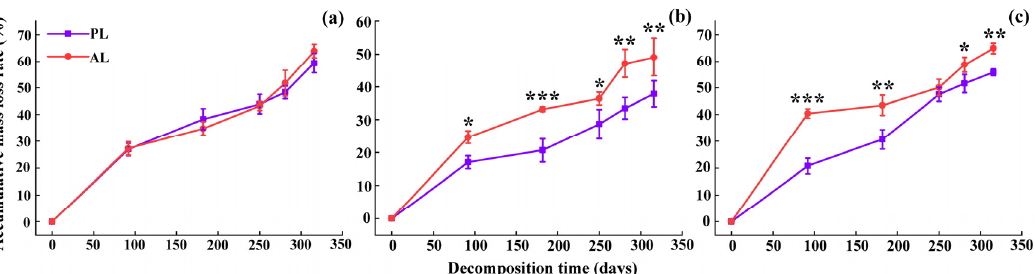
Figure 2. The accumulative mass loss rates (%) of goldenrain tree ( a ), camphor tree ( b ), and weeping willow tree ( c ) foliar litter in the urban forest. PL and AL indicate physiological and abnormal litter, respectively. * p < 0.05, ** p < 0.01, *** p < 0.001. Table 2. The decomposition constant, correlation coefficient, and time of 50% and 95% decomposition of foliar litter from different sources for the three species in the urban